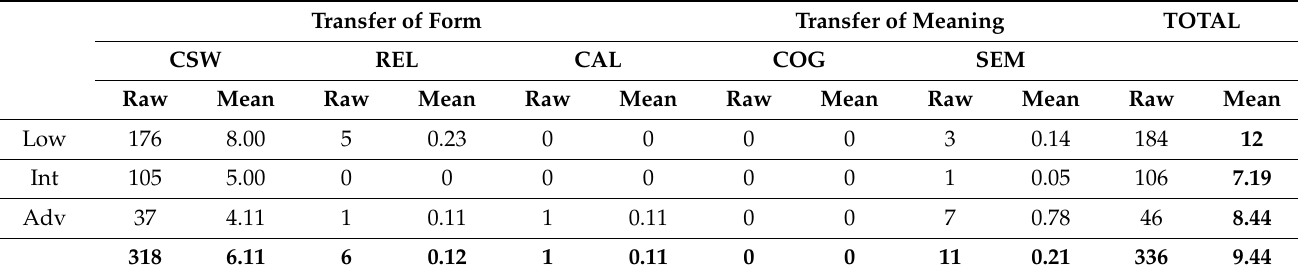
Table 6. Lexical CLI instances in oral production.